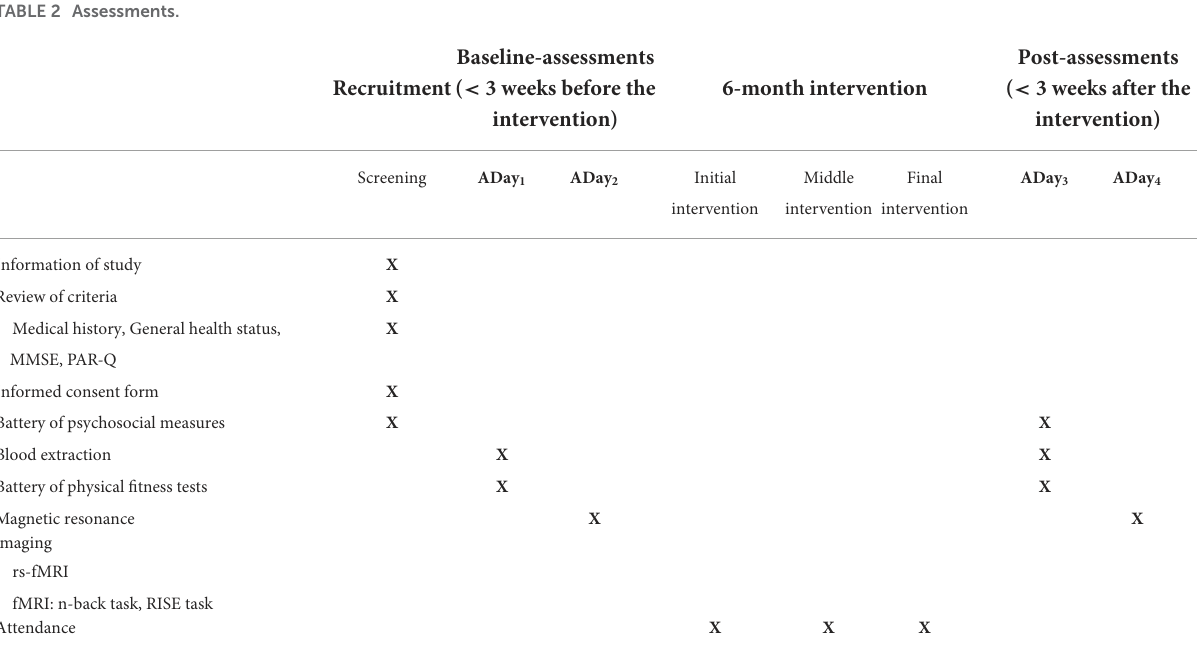
TABLE 2 Assessments.